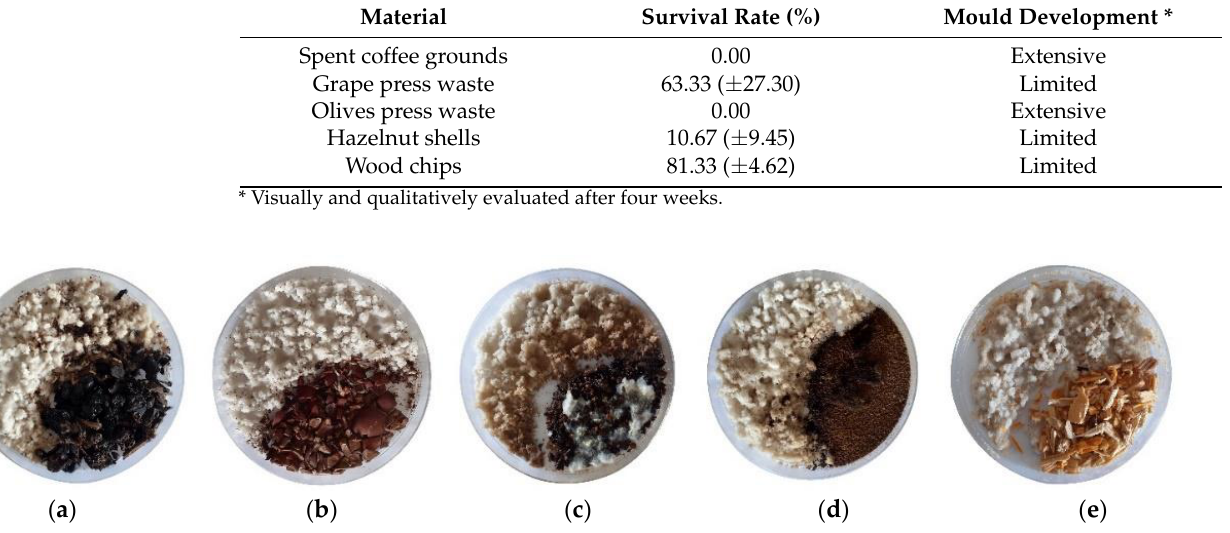
Figure 11. Termites ’ survival and mould growth after four weeks exposure: ( a ) grape press waste; ( b ) hazelnut shells; ( c ) olive press waste; ( d ) spent coffee grounds; ( e ) wood chips.